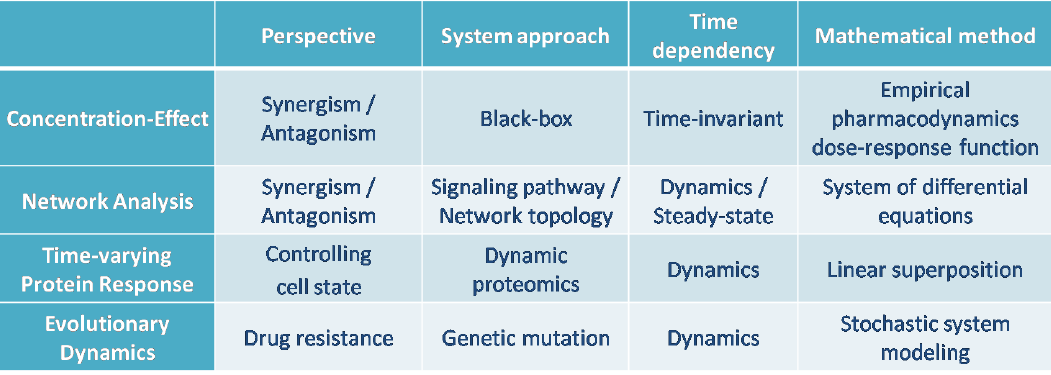
Figure 14. Comparison between the mathematical methods for drug